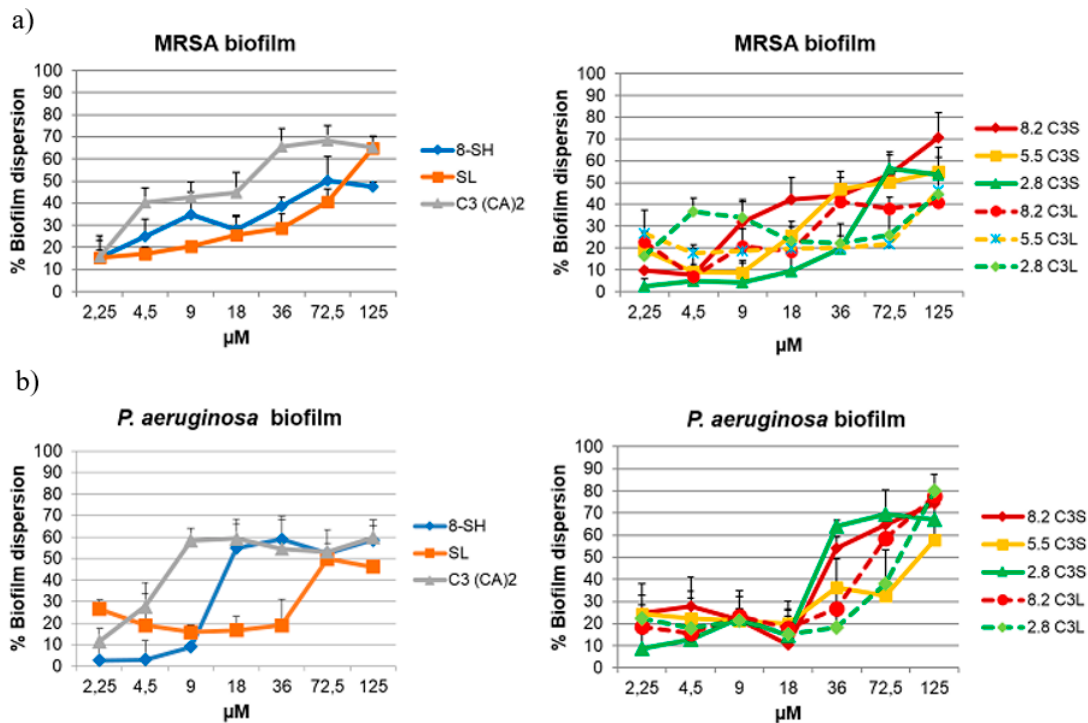
Figure 7. ( a ) MRSA biofilm dispersion (%) against concentration ( µ M) of pure surfactants and their catanionic mixtures, ( b ) P. aeruginosa biofilm dispersion (%) against concentration ( µ M) of pure surfactants and their catanionic mixtures.